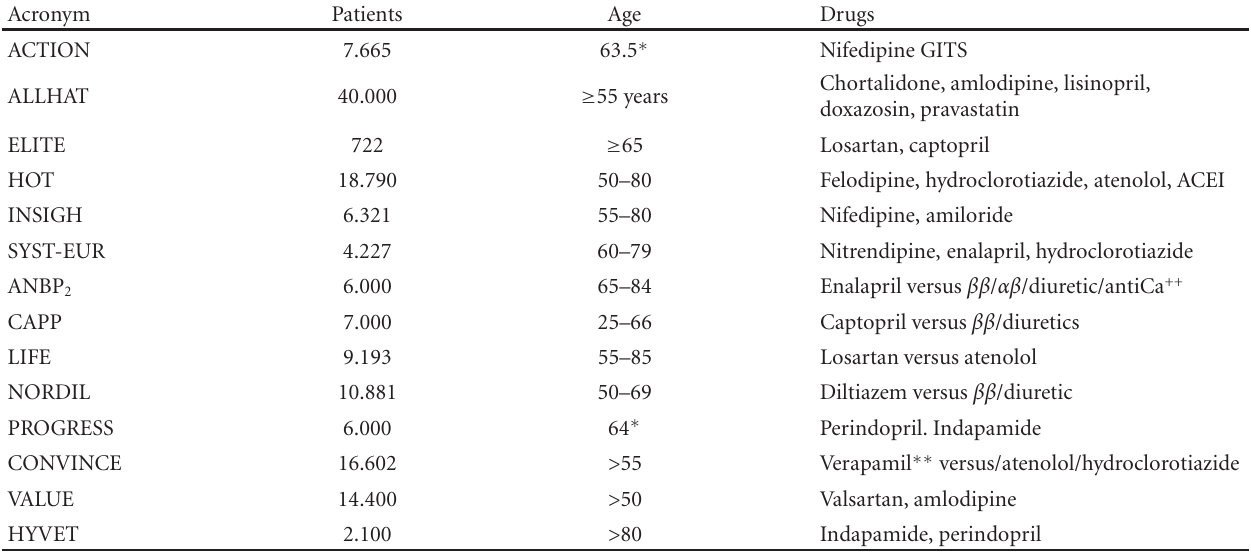
Table 1: main clinical trials on hypertensive